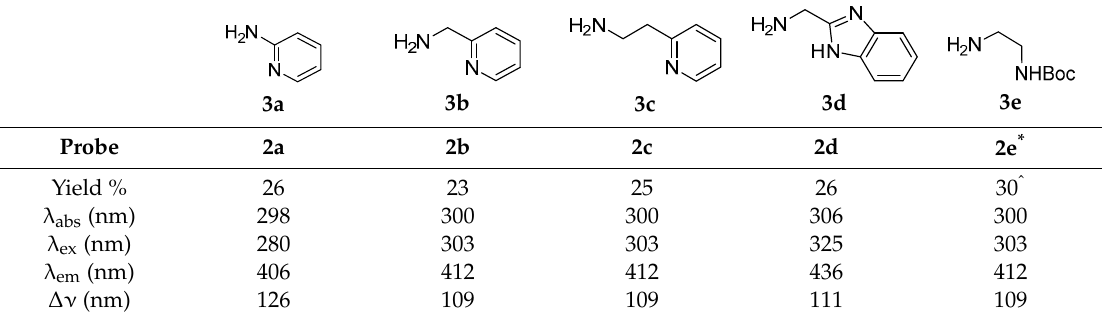
Table 1. Selected amines 3a – e , synthesized coumarin derivatives 2a – e , and their corresponding yields (%), absorption maxima, excitation and emission maxima, and Stokes shifts.